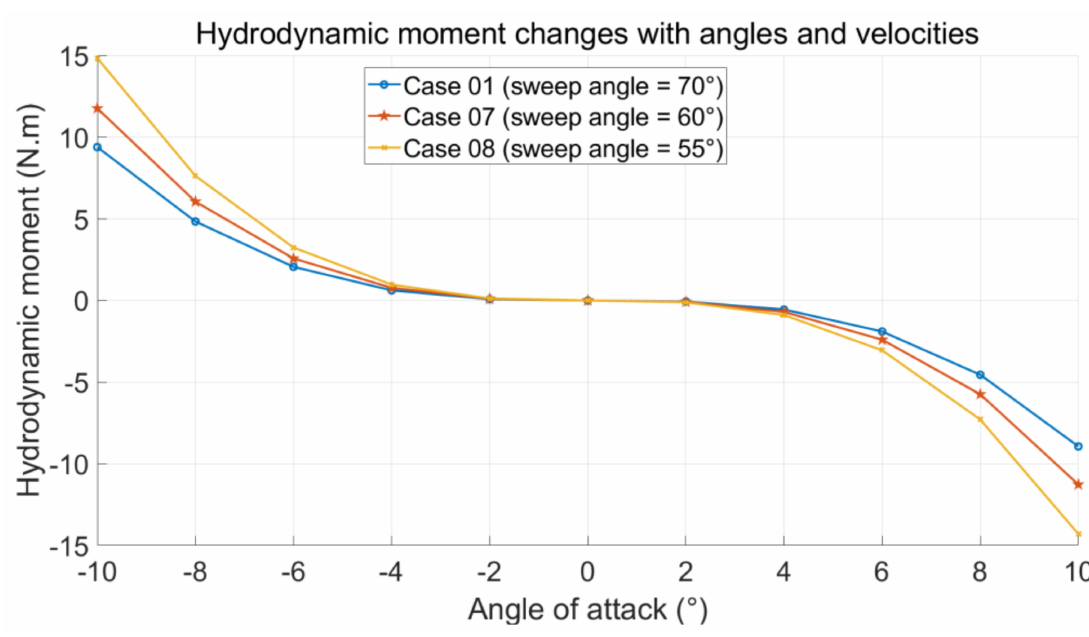
Figure 12. Changes in the hydrodynamic moment with angles and velocities. Based on the aforementioned simplified equations of glider motion, the gliding speed and angle were simulated for six cases under the same displacement of the movable mass block and piston. Furthermore, the presented glide path is the maximum permissible for the glider structure. Figures 13–15 display the simulation